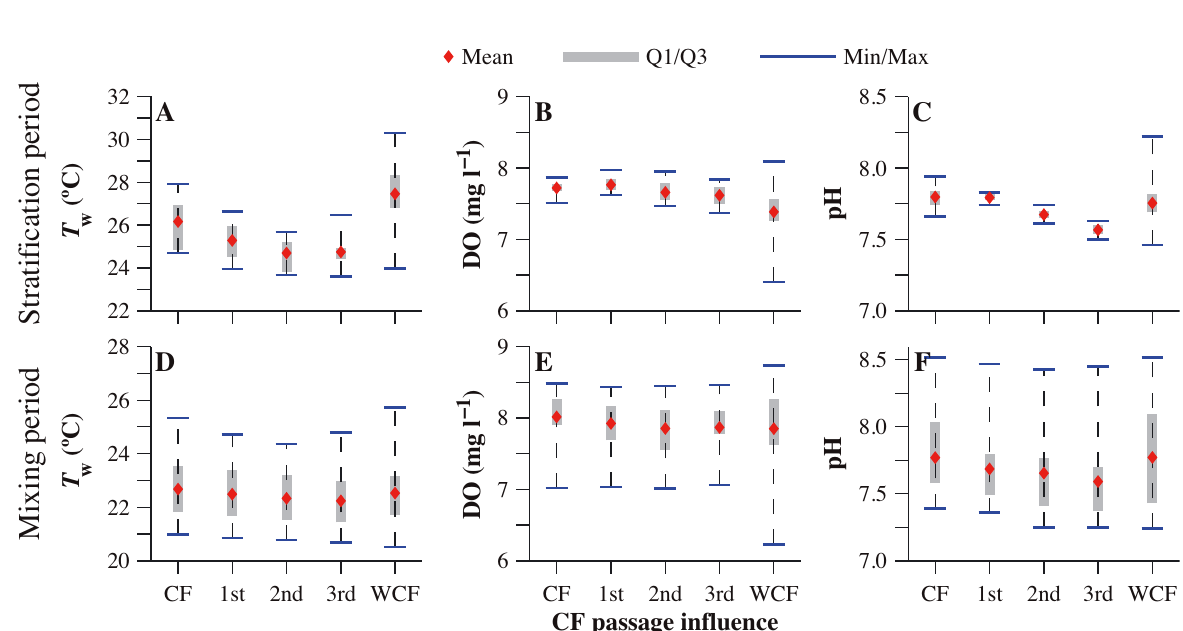
Fig. 9. Mean, 1 st quartile, 3 rd quartile, minimum, and maximum values of (A,D) water temperature ( T w ), (B,E) dissolved oxygen (DO), and (C,F) pH, at platform #1C, for the (A−C) stratification and (D−F) mixing periods, on days without (WCF) and with (CF) the influence of cold fronts (including the 1 st , 2 nd , and 3 rd days after its